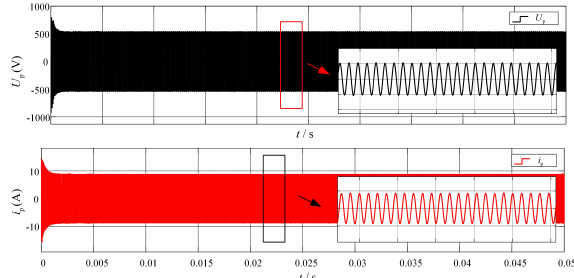
Fig. 11. Simulation waveform of transmitting coil voltage u p and current i p